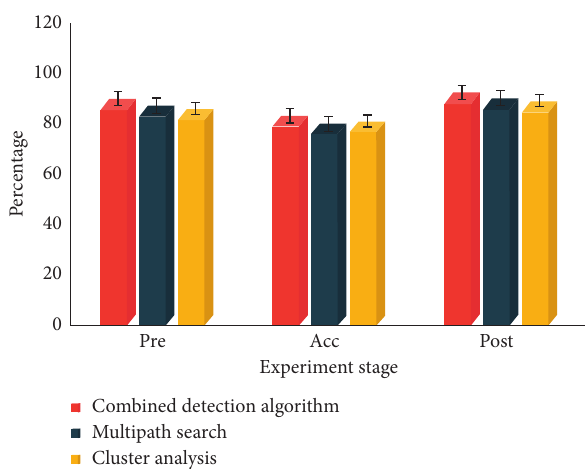
Figure 6: The result when the number of instruments is